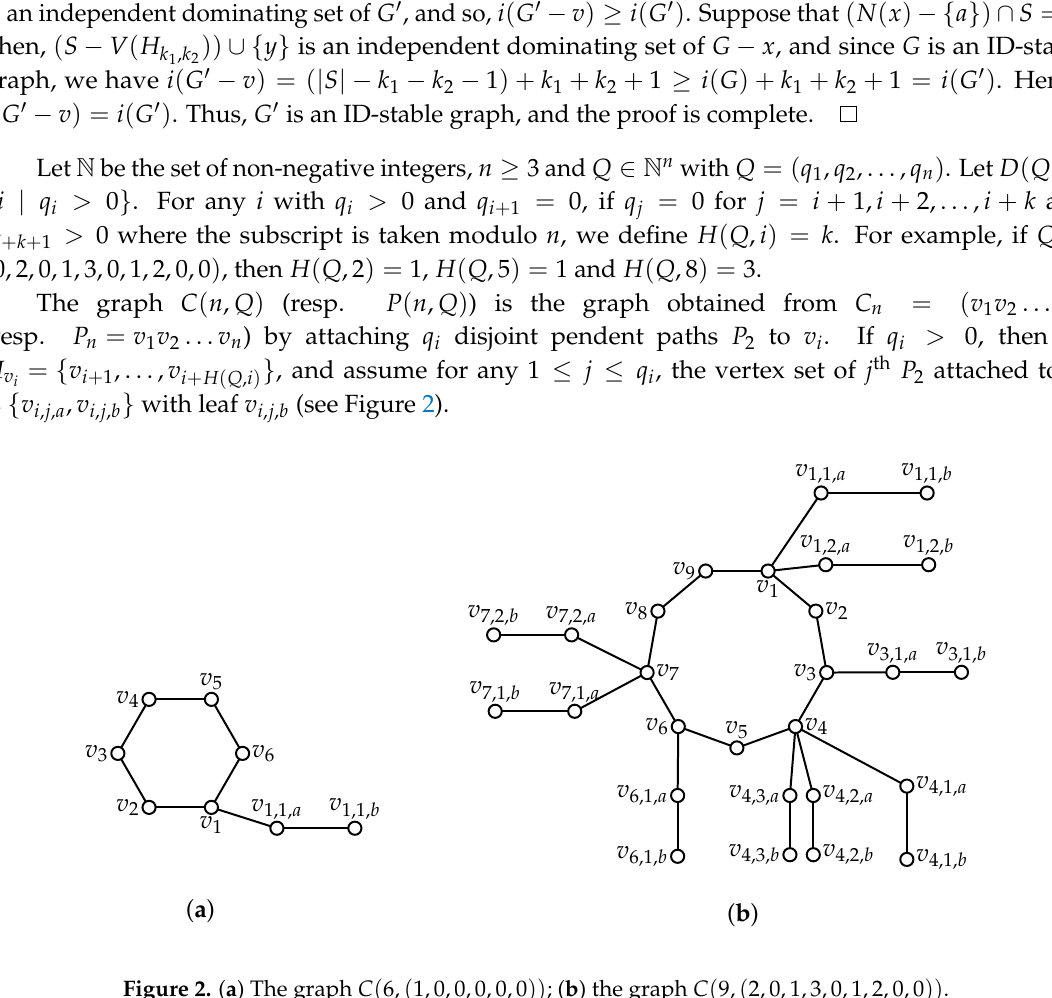
Figure 2. ( a ) The graph C ( 6, ( 1,0,0,0,0,0 )) ; ( b ) the graph C ( 9, ( 2,0,1,3,0,1,2,0,0 ))